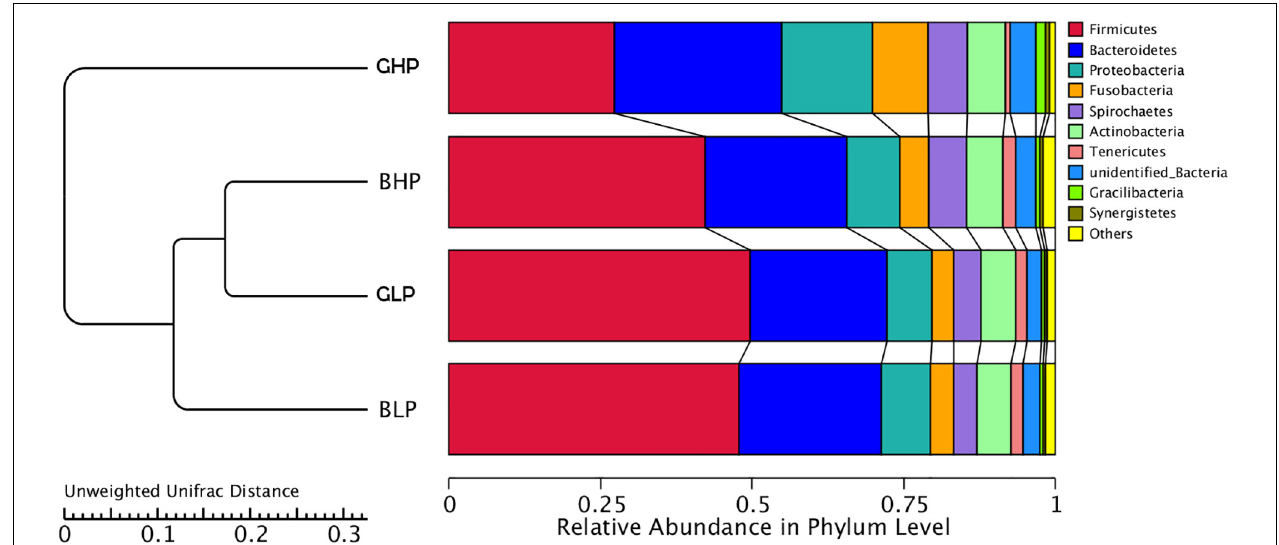
Table 3 , the score plot of LC-MS [electrospray ionization negative (ESI-)] data with 2,037 metabolite signals and LC-MS (ESI+) data with 3,844 metabolite signals were